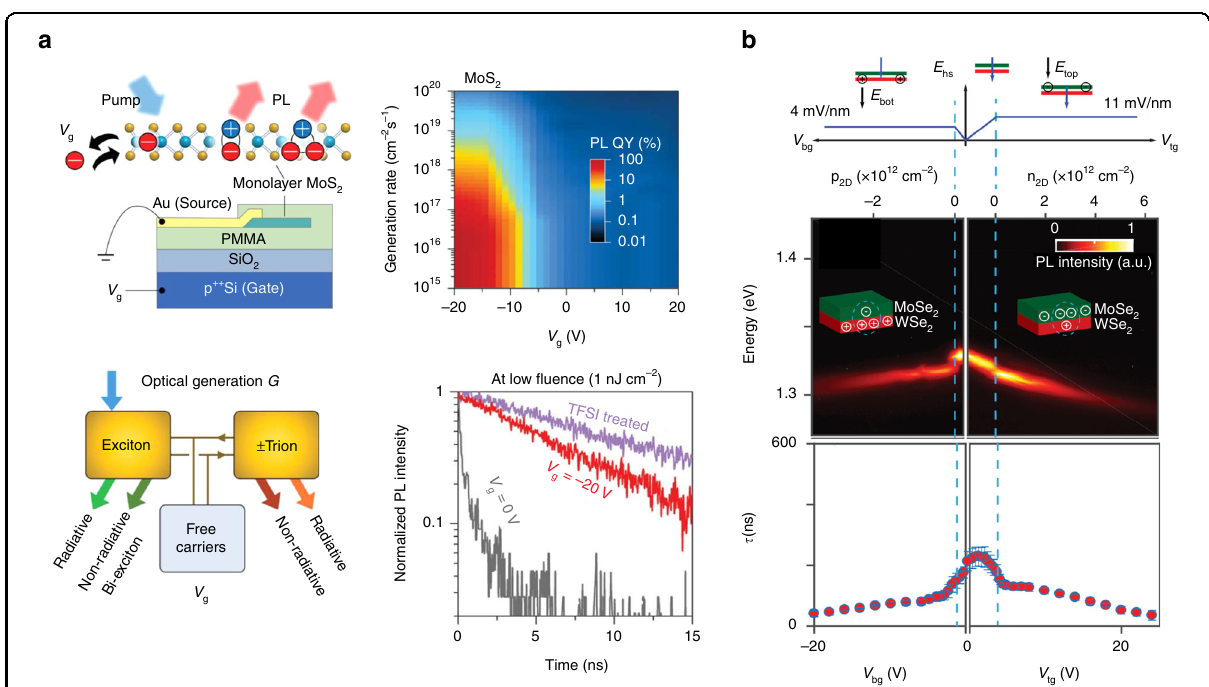
Fig. 8 Transitions among different quasiparticles. a Near-unity photoluminescence (PL) quantum yield in MoS 2 through electrostatic doping compensation. (Top left) Schematic showing control of different quasiparticles by back-gate voltage V g and photocarrier generation rate G . (Top right) MoS 2 PL QY versus G and V g . (Bottom left) Proposed exciton and trion recombination pathways in TMD materials. (Bottom right) Time-resolved PL of TFSI-treated MoS 2 (purple) and a MoS 2 device under V g = 0 V (black) and V g = – 20 V (red) at a pump fl uence of 1 nJ/cm 2 . b Carrier density control of interlayer excitons in a MoSe 2 /WSe 2 heterostructure. (Top) The calculated electric fi eld across the heterostructure E hs versus the top and bottom gate voltages ( V tg and V bg ). The top cartoons represent the heterostructure for different applied gate voltages. (Middle) Single-gate dependence ( V tg or V bg ) of the PL showing the formation of charged interlayer excitons with varying carrier density obtained from the gate operation scheme in the top panel. (Bottom) Neutral and charged interlayer exciton lifetime τ versus carrier density. Figure reproduced with permission from a ref. 89 ., © 2019 AAAS; b ref. 84 , © 2019